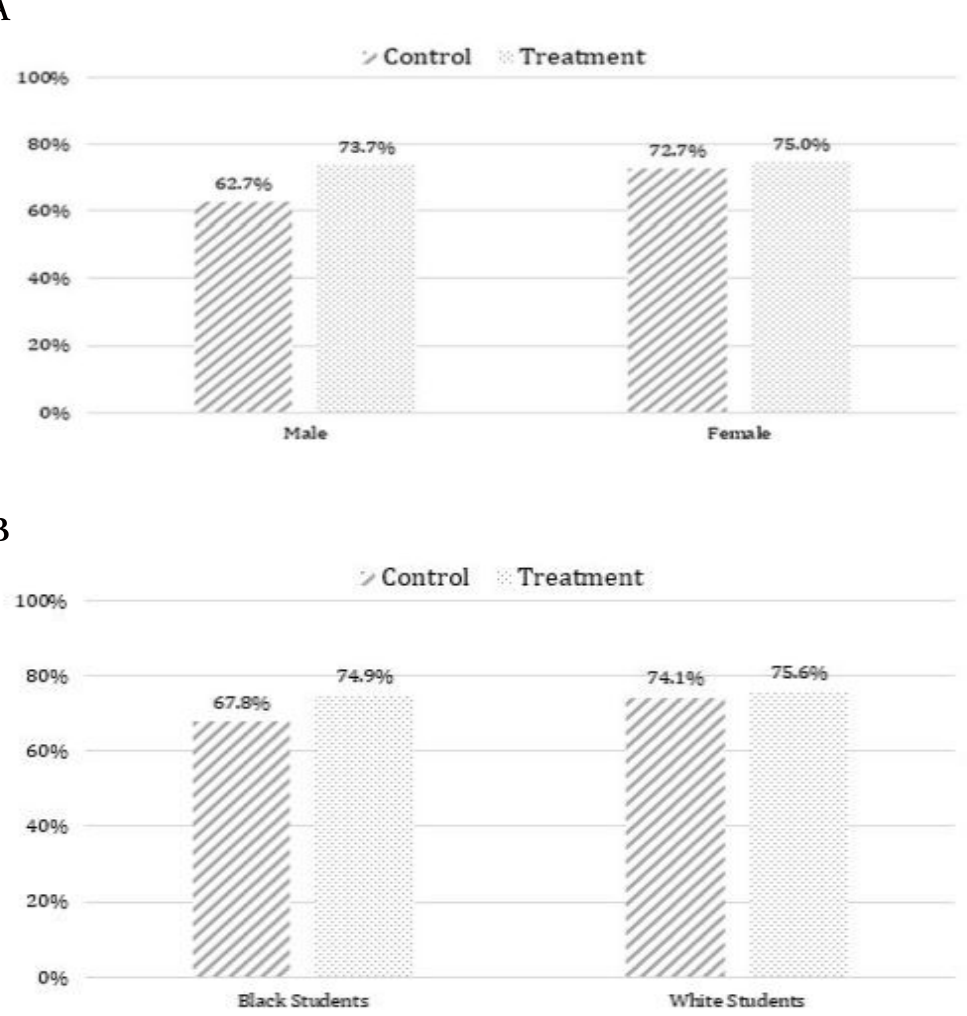
Figure 1: Interactions between Experimental Condition and (A) Gender, (B) Race, and (C) Spring 2020 Enrollment on Fall 2020 Term